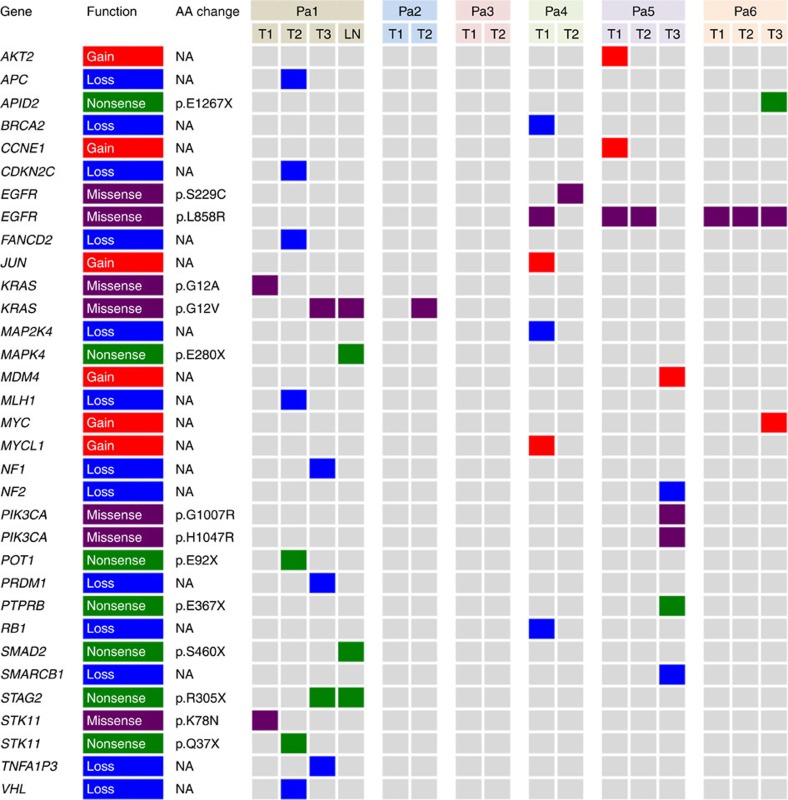
Nonsynonymous point mutations and copy number changes in known cancer genes in 16 intra-thoracic lesions of six patients with MSLC.Copy number changes were defined on the basis of segment log2 ratios derived from microarray-based CGH, with log2 ratios >0.3 categorized as copy number gains and log2 ratios <−0.3 categorized as copy number losses. AA, amino acid; LN, lymph node metastasis; NA, not applicable; T, tumour number.